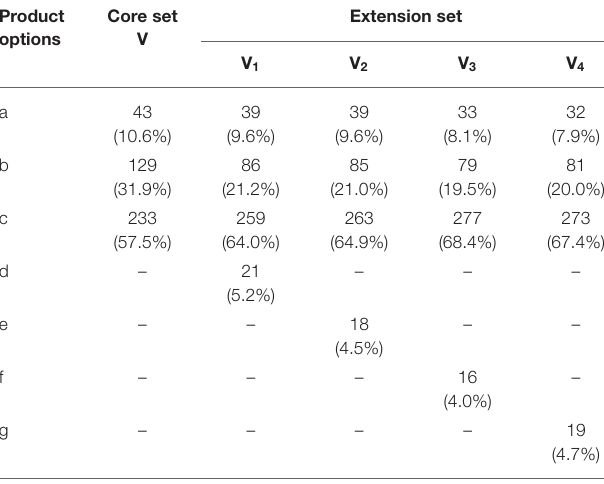
TABLE 6 | The absolute purchase share in the pork hindquarter experiment.